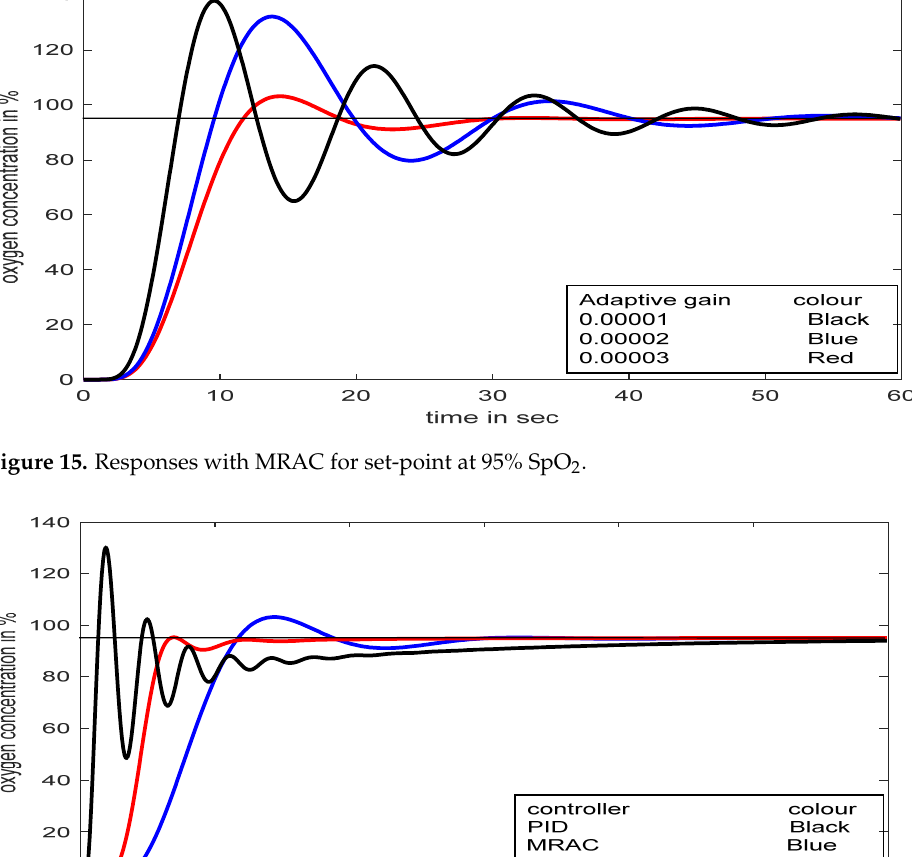
Figure 14. Comparative studies of different time constants of oxygen cylinder model with the proposed controller.